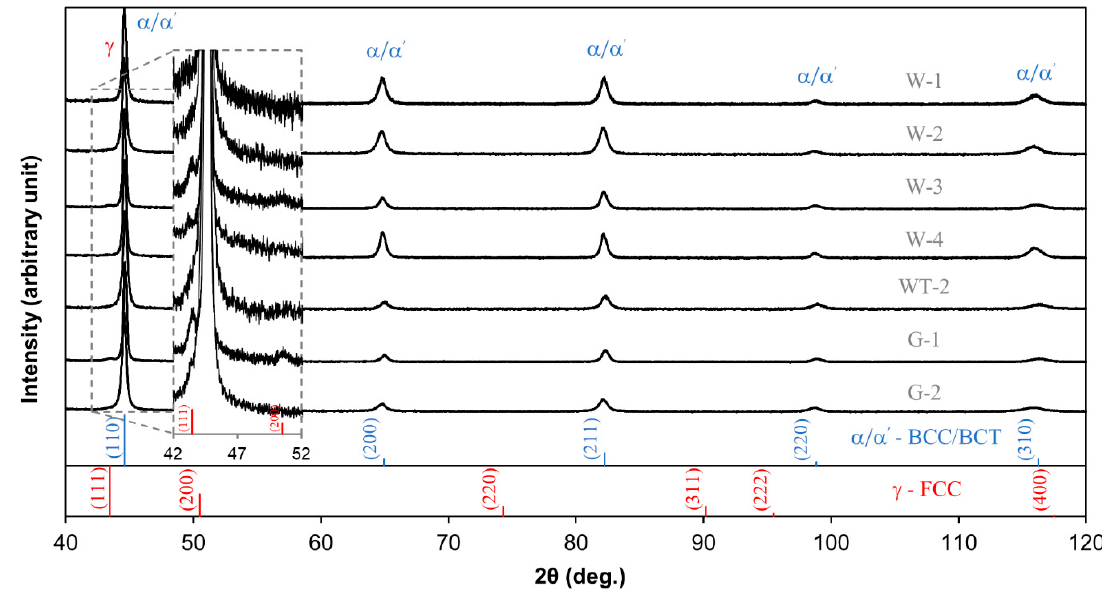
Figure 7. X-ray diffractometer (XRD) patterns of the L-PBF processed steels indicating α / α ’ - BCC/BCT Figure 7. X-ray di ff ractometer (XRD) patterns of the L-PBF processed steels indicating α / α ’-BCC / BCT and γ - FCC peaks. and γ - FCC